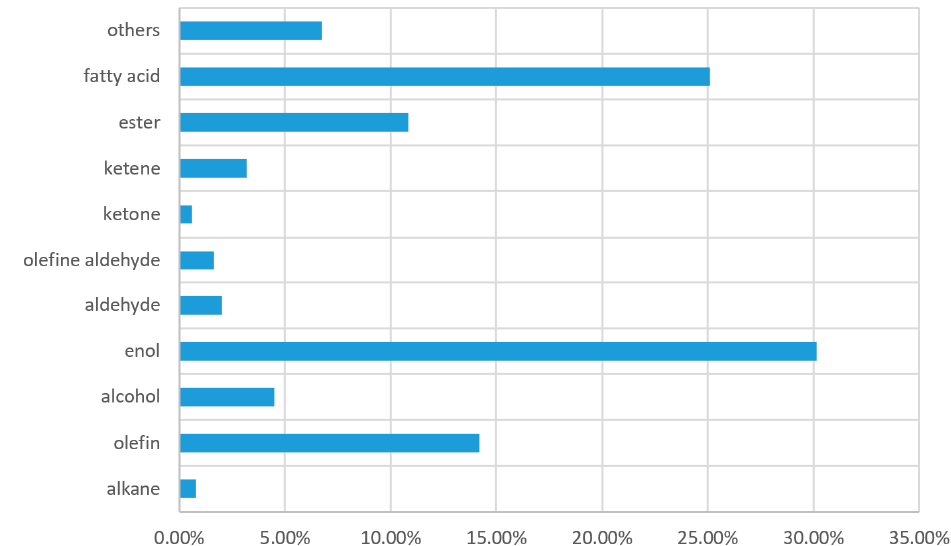
Figure 5. Classification of different compounds in the chemical composition of essential oils from T. triquetrum (L.) Ohashi.